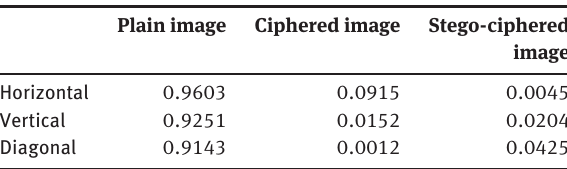
Fig. 6: Hand: (a) Original image, (b) Ciphered image, (c) Stego- image, (d) Decrypted image. Table 3: Lung cancer: Correlation analysis of two adjacent pixels.